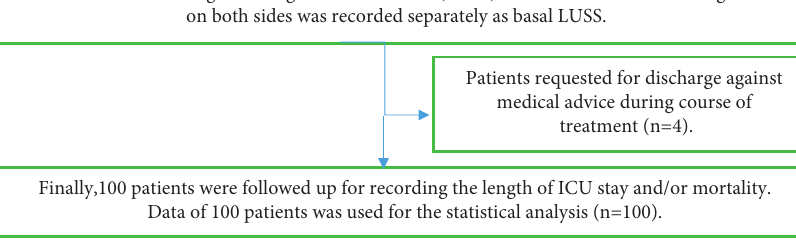
Figure 1: Flowchart depicting the methodology of the study. Table 1: Lung ultrasound score calculation based on ultrasound